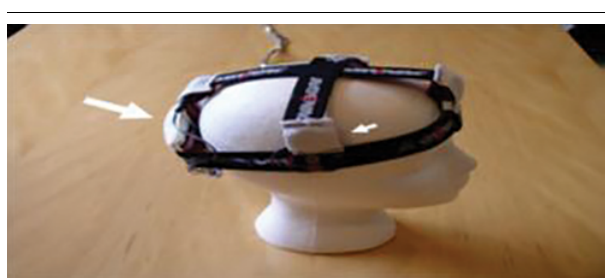
Sensory substitution devices Nonimplanted vestibular prostheses (vibro-tactile stimulation)